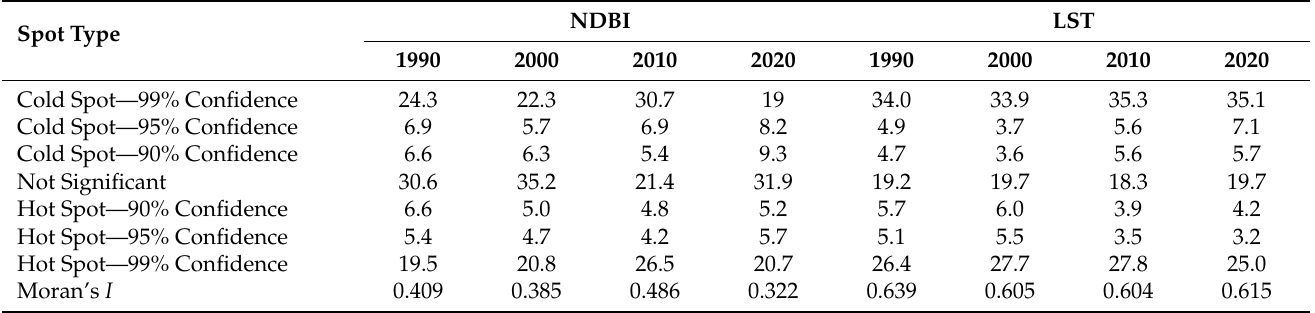
Table 6. A summary of area coverage by hot, cold, and not-significant spots, along with Moran’s I values, for both NDBI and LST from 1990 to